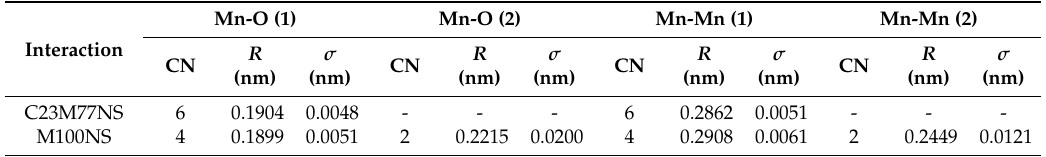
Table 1. Structural parameters of restacked C23M100NS and M100NS determined by analyzing the Mn K-edge EXAFS spectra. CN, R and σ denote coordination number, bond length and Debye–Waller factor,